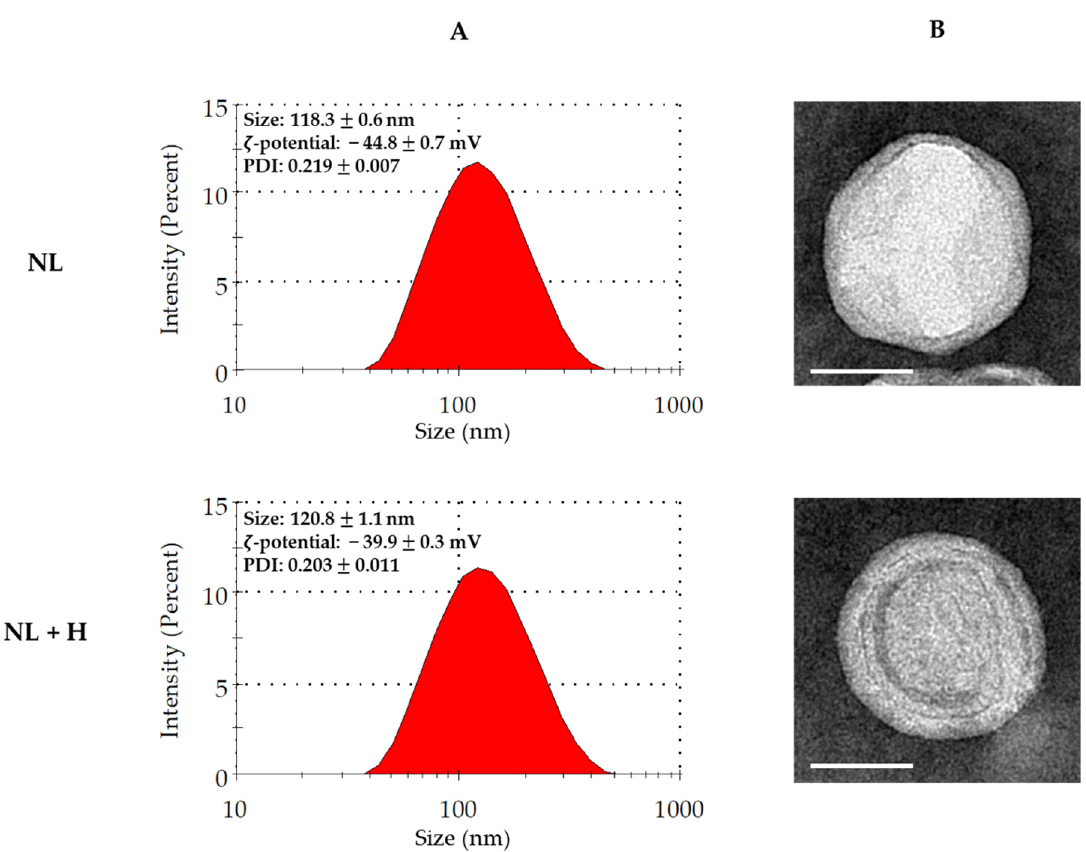
Figure 2. Physicochemical characterization of empty and hop-extract-loaded rapeseed lecithin liposomes. ( A ) Graphical representation of size distribution, average size, ζ -potential, and PDI of rapeseed lecithin nanoliposomes measured by DLS. ( B ) Representative TEM pictures of rapeseed lecithin liposomes. The white scale bar corresponds to 50 nm. DLS—dynamic light scattering; NL—empty nanoliposomes; NL + H—hop-extract-loaded nanoliposomes; PDI—polydispersity index; TEM—transmission electron microscopy; SD—standard deviation. The numerical data are represented as mean ± SD of at least three individual experiments.